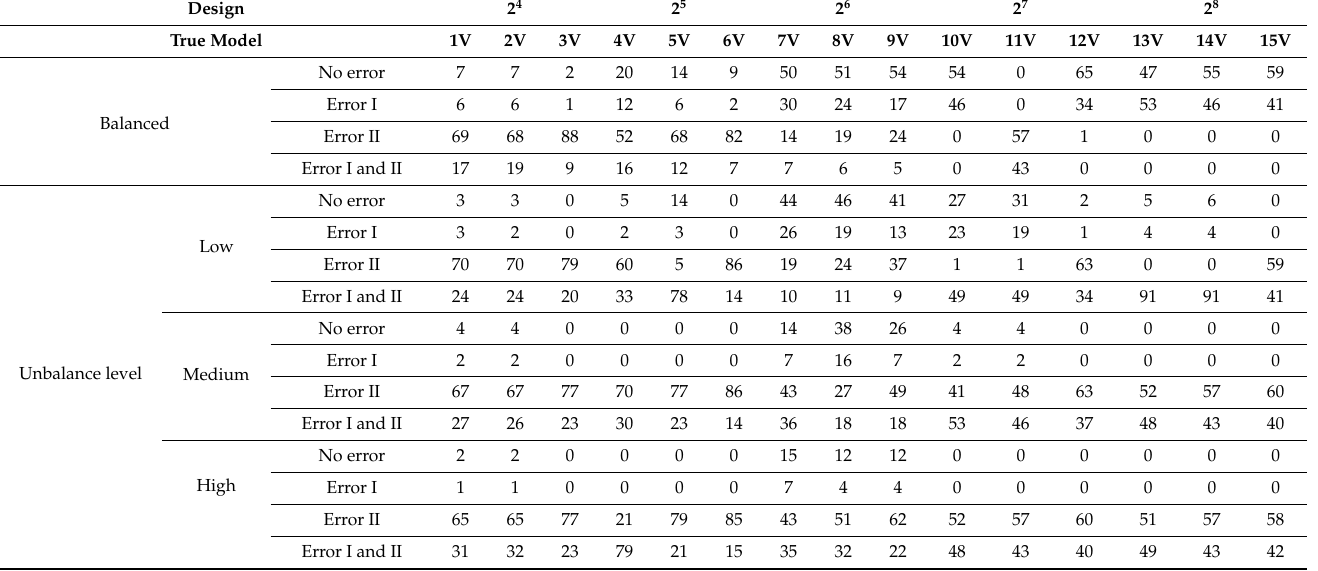
Table 10. % Error behavior with very high